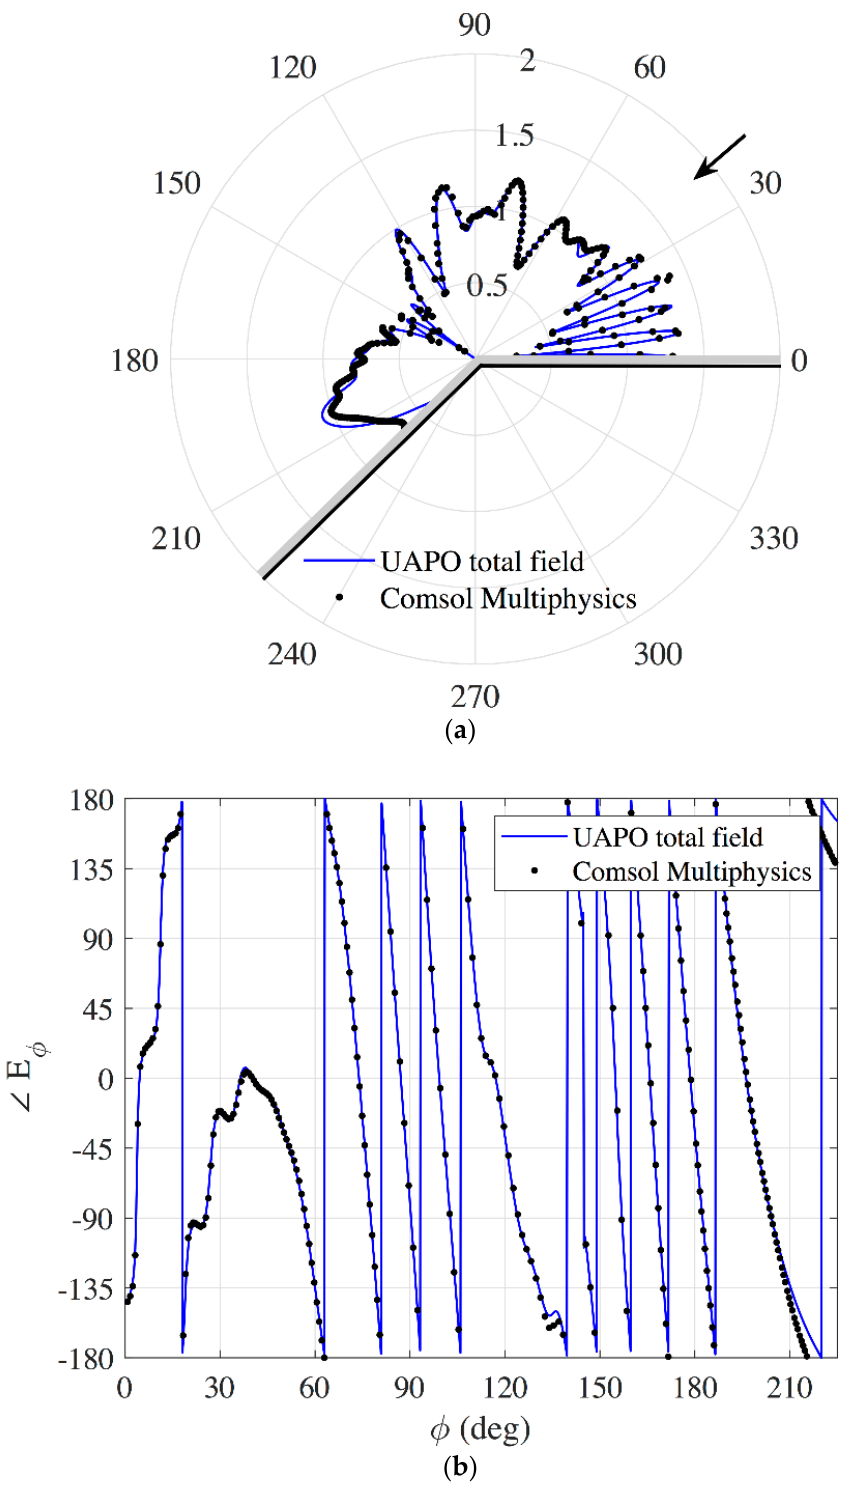
i = i = = 0, E i = 1. 0 , E 1 . ( a ) φ (cid:48) β (cid:48) b ' f '